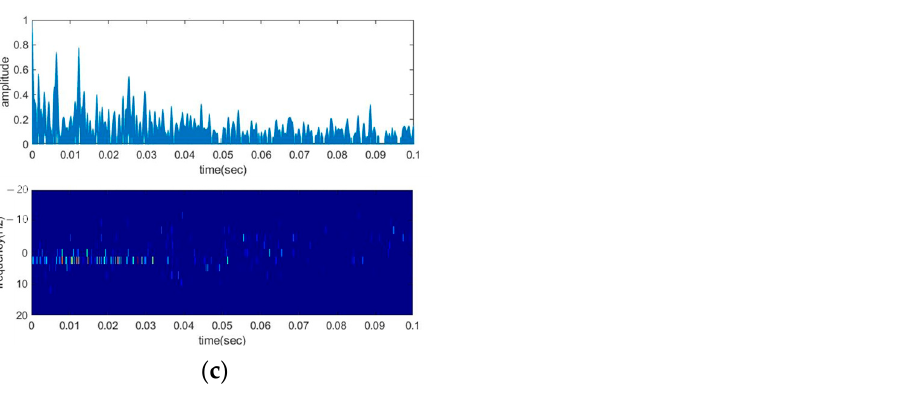
Figure 11. Lake experiments environments ( a ) Location, ( b ) Configuration, ( c ) delay profile, and doppler spread.